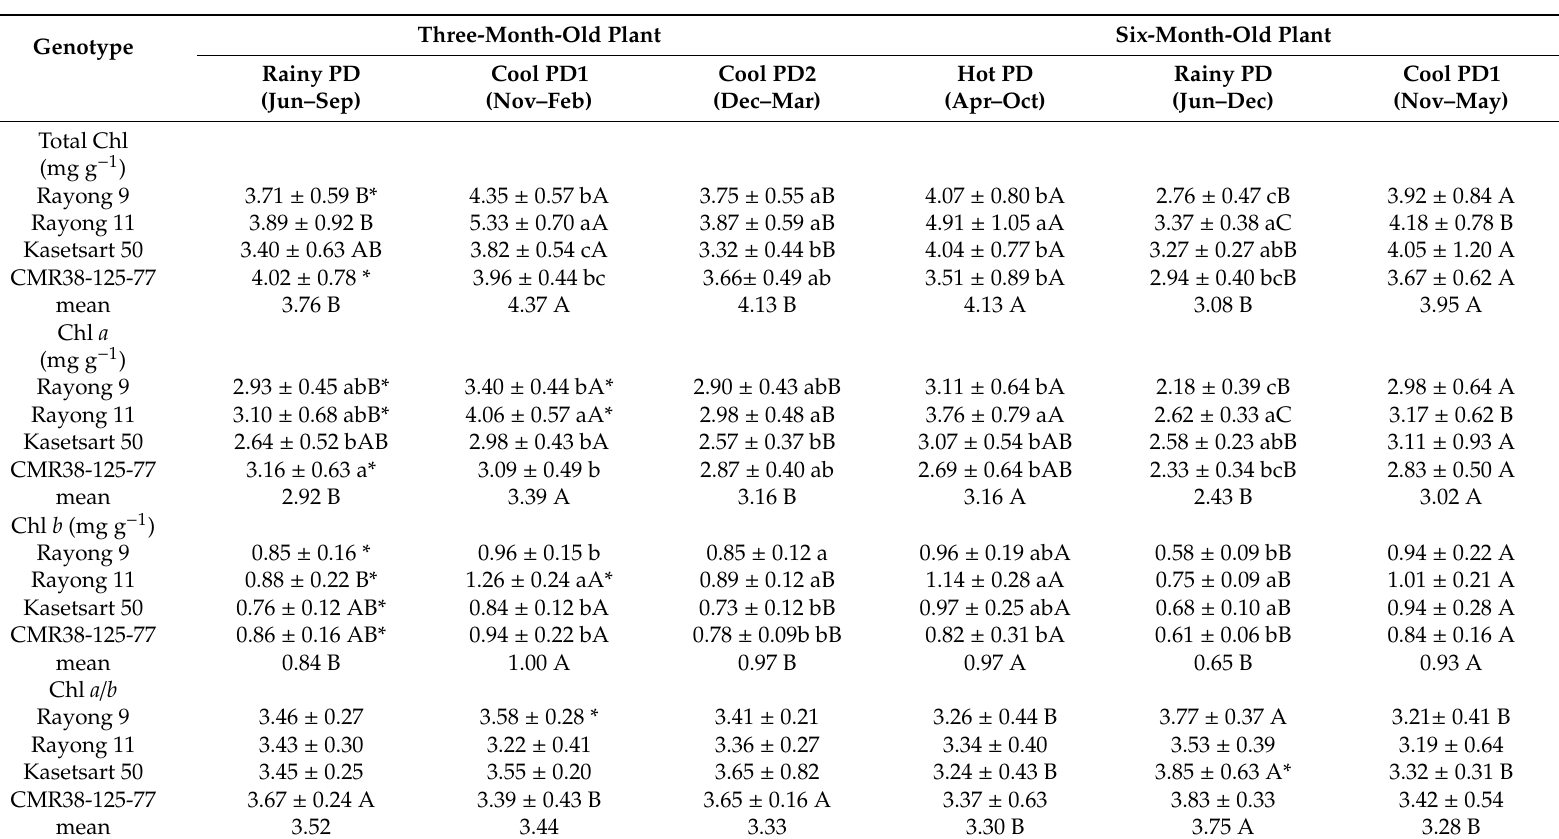
Table 4. Means total Chl, Chl a , Chl b , and Chl a / b across six canopy levels of 3- and 6- month-old cassava plants. Four cassava genotypes including Rayong 9, Rayong 11, Kasetsart 50, and CMR38-125-77 were planted in April (Hot PD), June (Rainy PD), November (Cool PD1), and December (Cool PD2) in 2015. Mean ± SD were from 18 measurements (six canopy levels x three plants). Means that were significantly di ff erent ( p < 0.05) among genotypes are denoted with di ff erent lower case letters, whereas those among PDs are represented by di ff erent capital letters. The significant di ff erences ( p < 0.05) between the 3- and 6-month-old plants in the same PD are denoted with